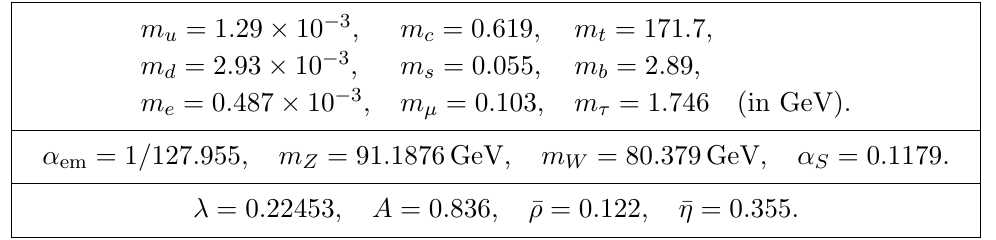
Table 2 . Input values for the SM parameters at the scale of m Z . We refer to refs. [95, 96] for the fermion masses at m Z . The other parameters in the table are taken in ref. [97]. The parameters in the last line are the Wolfenstein parameters of the CKM matrix